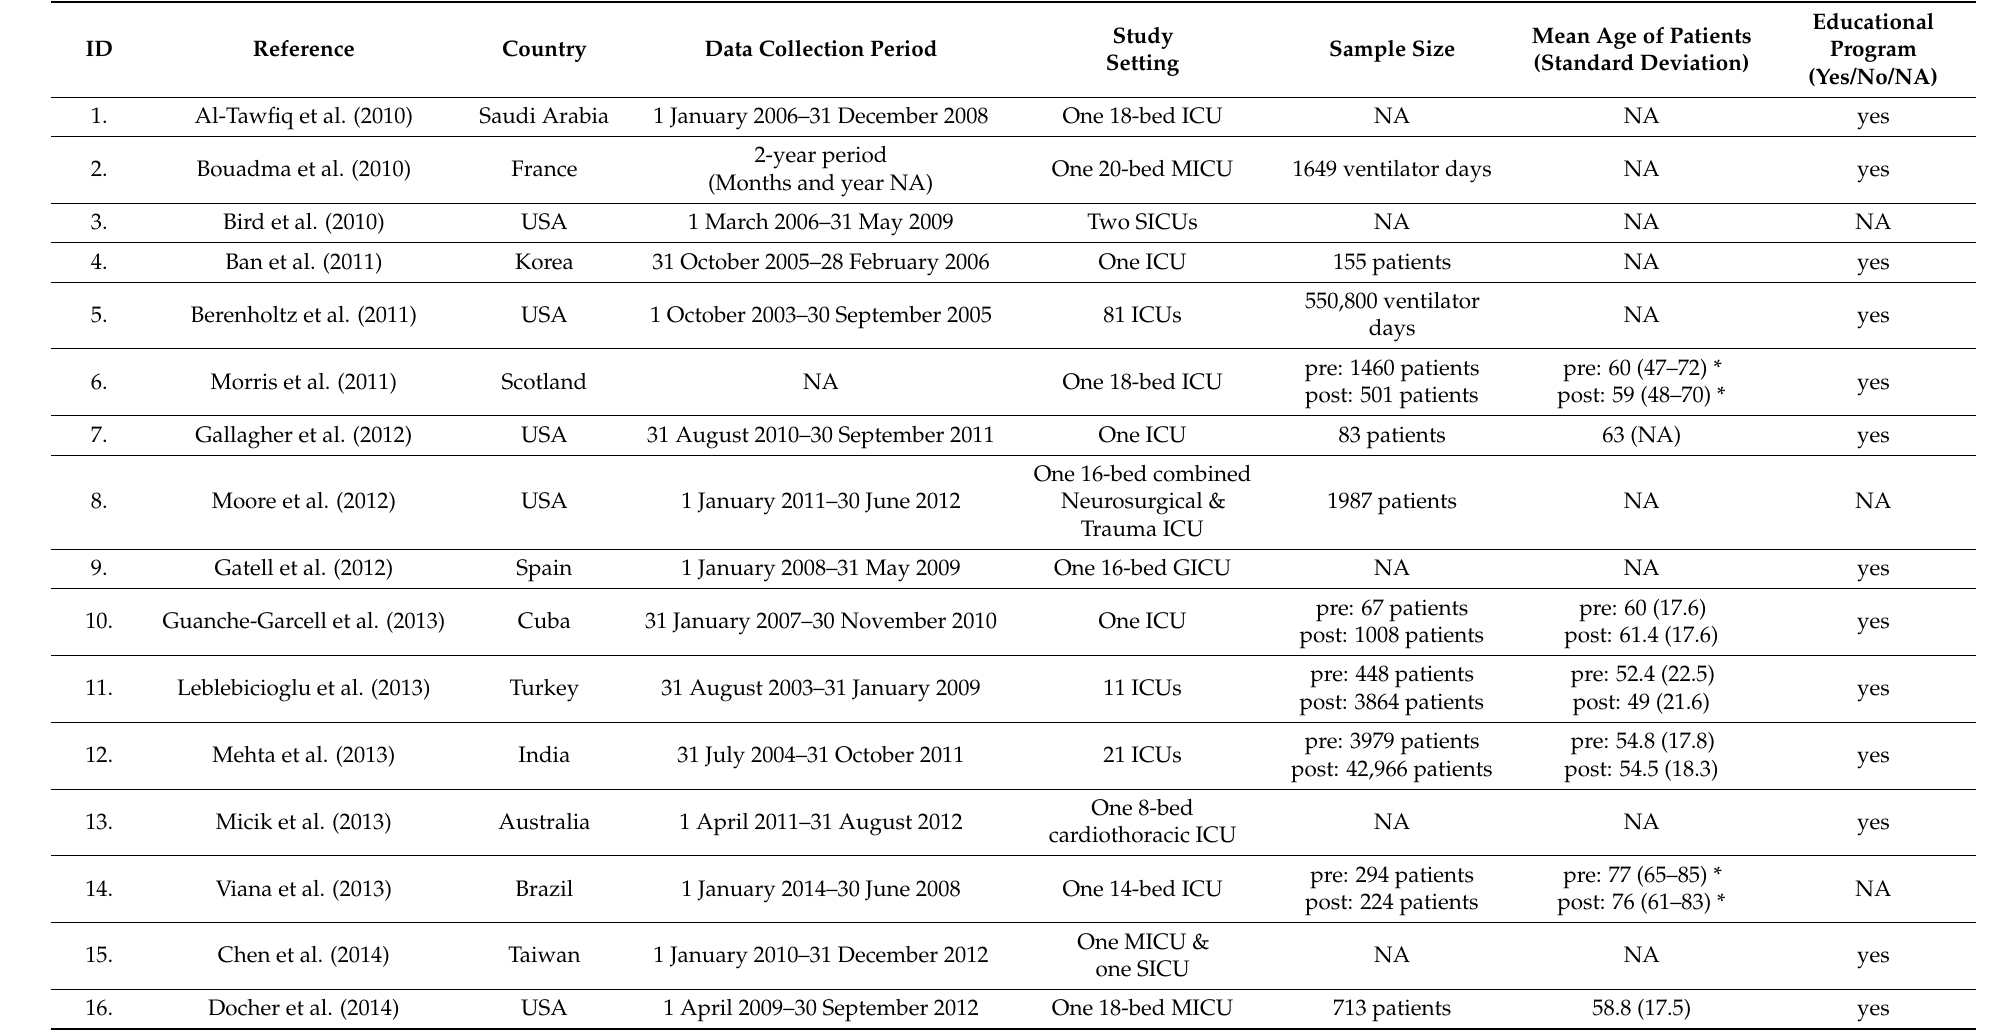
Table 1. Main characteristics of the reviewed studies (n =